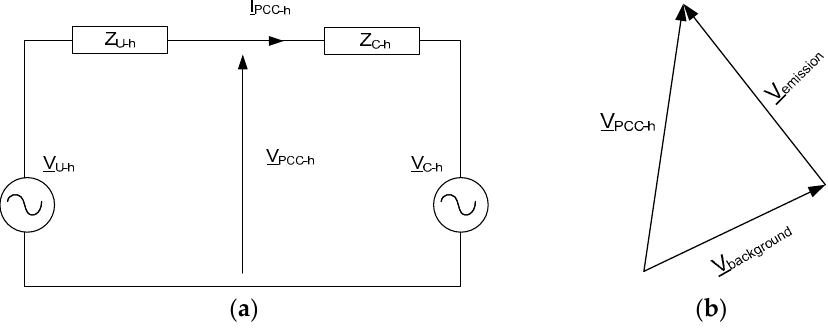
Figure 1. ( a ) Thevenin equivalent circuit for voltage harmonic vector method and IEC voltage phasor method; ( b ) Voltage phasor diagram for IEC voltage phasor method.